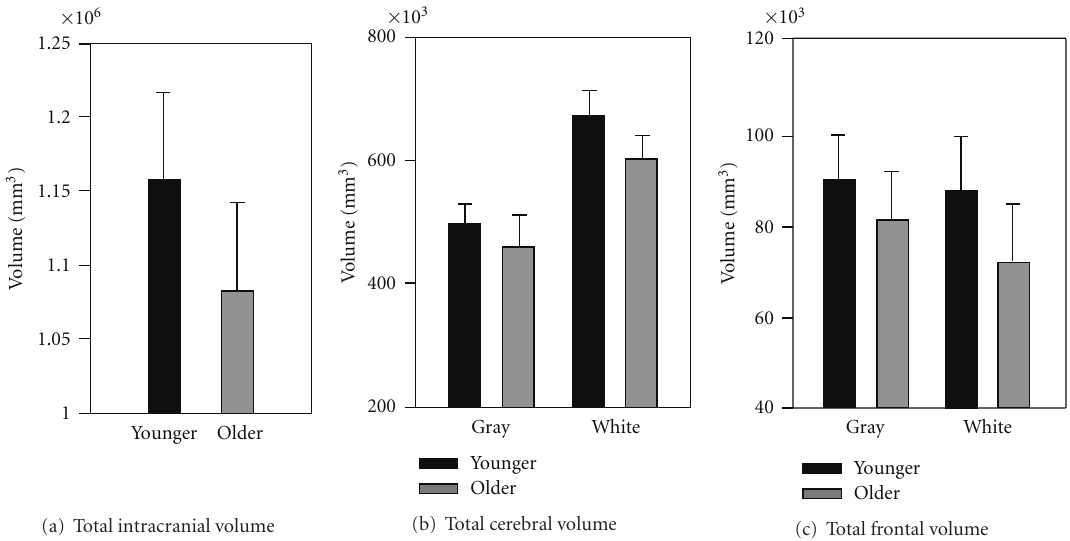
Figure 3: Volumetric data for older relative to younger adults for (a) total intracranial volume, (b) whole brain gray and white cerebral volumes (black bars, young; white bars, older), (c) prefrontal gray and white (black bars, young; white bars, older). Error bars represent 1